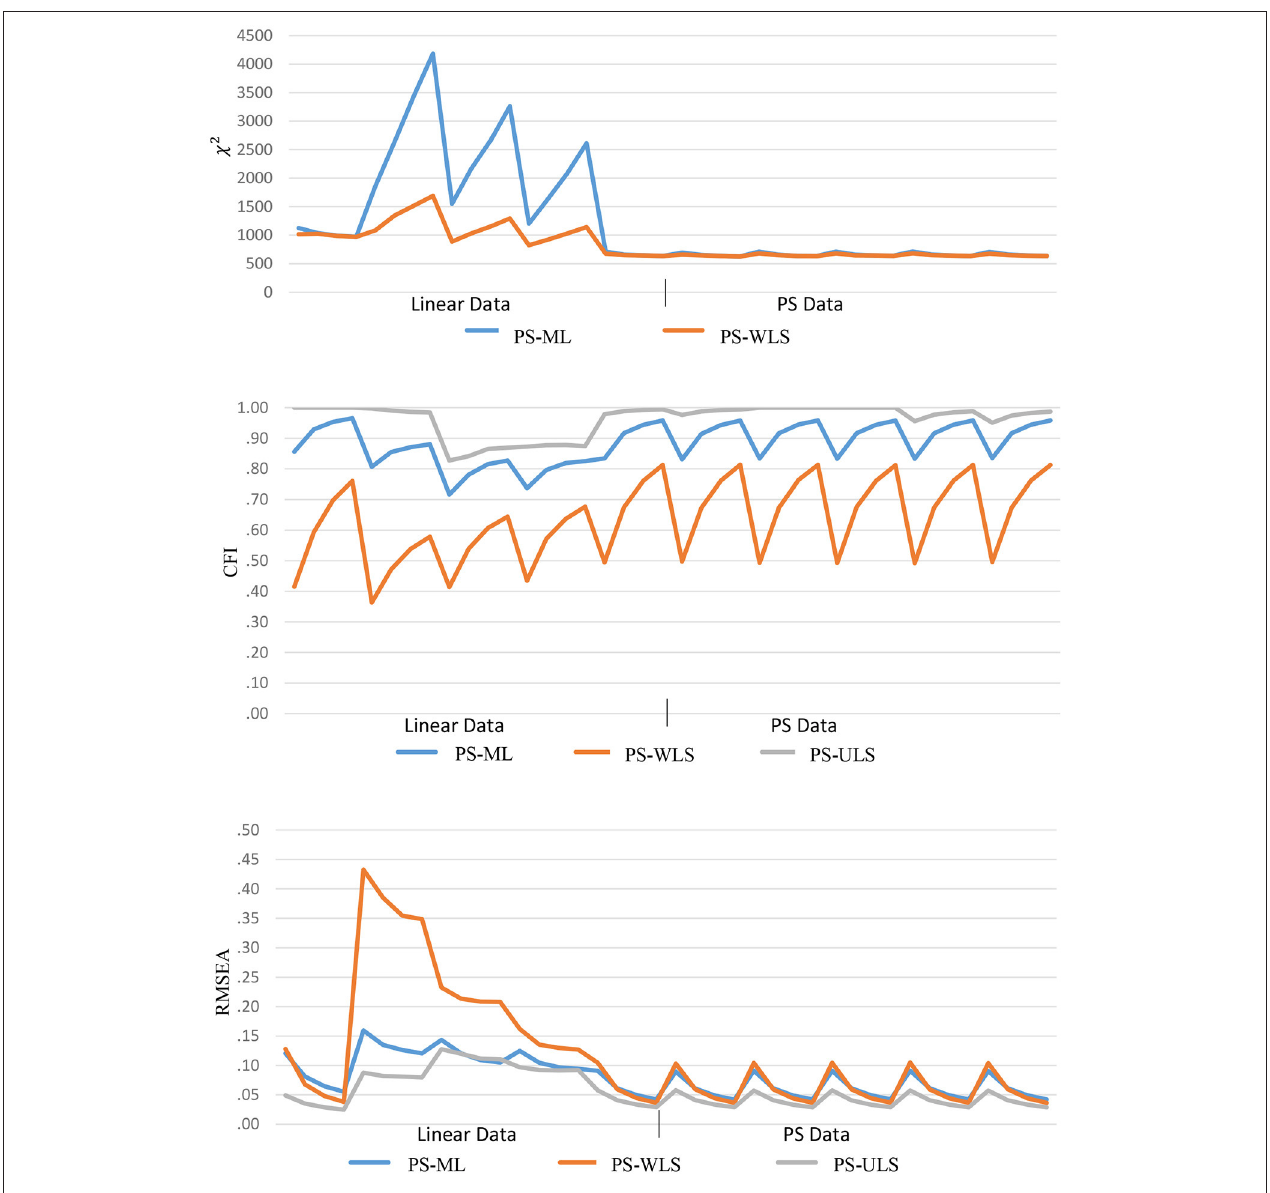
FIGURE 7 | Goodness-of-fit indices based on PS estimators across 40